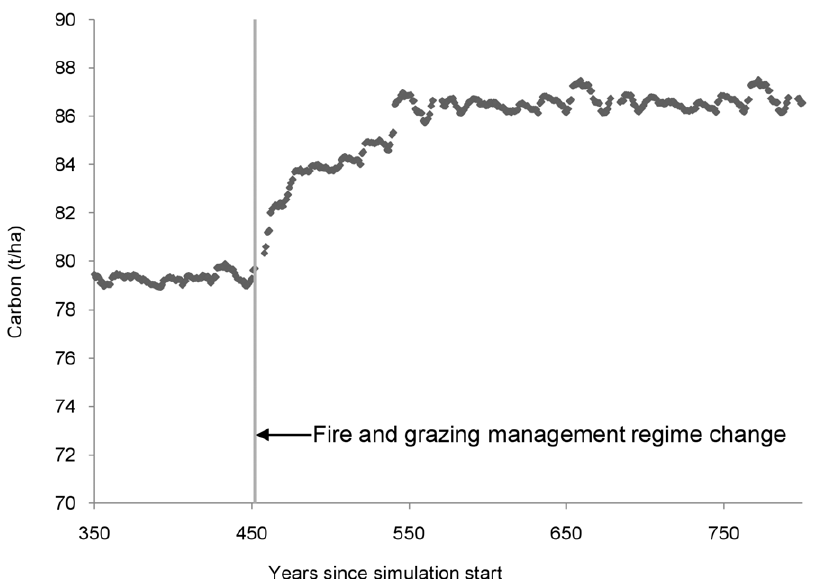
Figure 2. Carbon stock increases with a simulated improved fire and grazing management regime. The carbon density averaged across all vegetation zones was modelled by the state and transition carbon model, AuSavan [67]. The simulation was initiated using parameters representing a ‘business as usual’ scenario (i.e. no improved land management) and run for 4 cycles of 113 years ending at year 452. We then introduced a regime change by altering the parameters to reflect improved fire and grazing management.